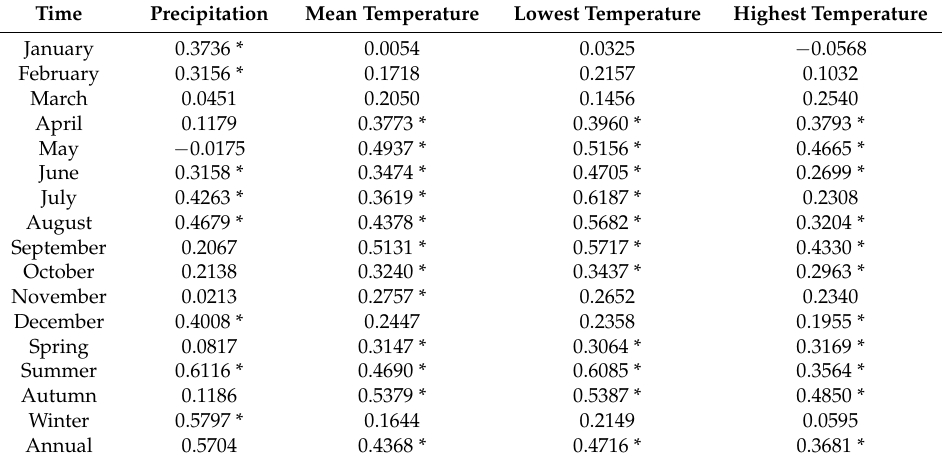
Table 3. Partial Correlation Coefficients (PCC) between runoff and climatic variables during the period of